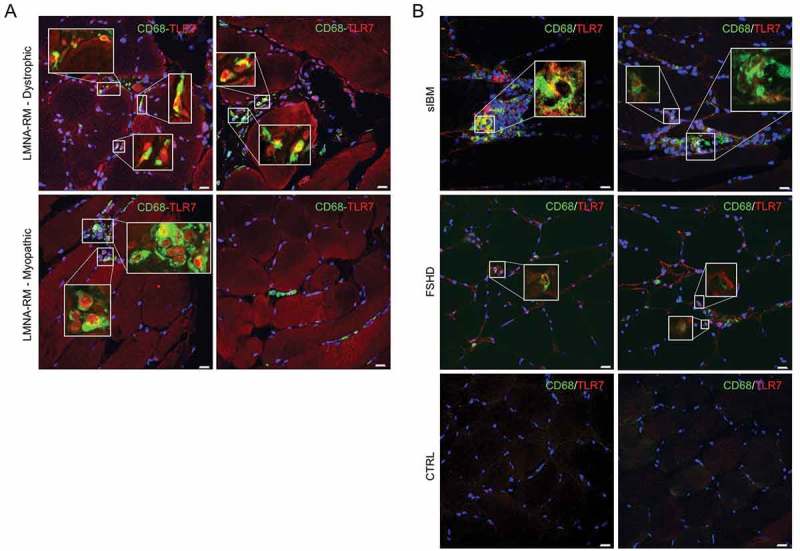
Quantification of macrophages residing in LMNA-RM muscle tissue. (a) Immunofluorescence showed the presence of CD68 (green) positive macrophages among discernable muscle inflammatory cells scattered or localized close to connective tissue deposits in LMNA-RM (mean ± SD: 11.83% ± 8.06). Colocalization between CD68 and TLR7 was highlighted in the insets. (b) Among pathological muscle samples, sIBM showed the highest percentage of CD68-TLR7 double positive cells (mean ± SD: 23.73% ± 6.95) whereas the lowest values of colocalization between the two molecules was observed in FSHD muscles (mean ± SD: 8.92% ± 1.72). Original magnification, X40 and X120 in the insets; bars: 20 μm.